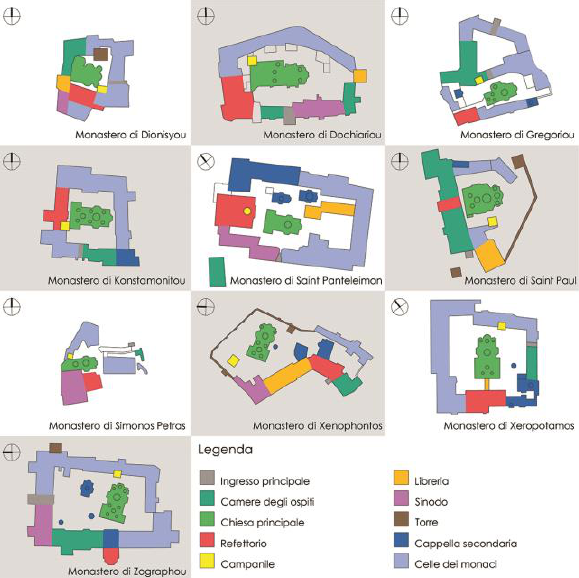
Figure 25 . The Monasteries of Mount Athos. Graphic diagrams of the compared